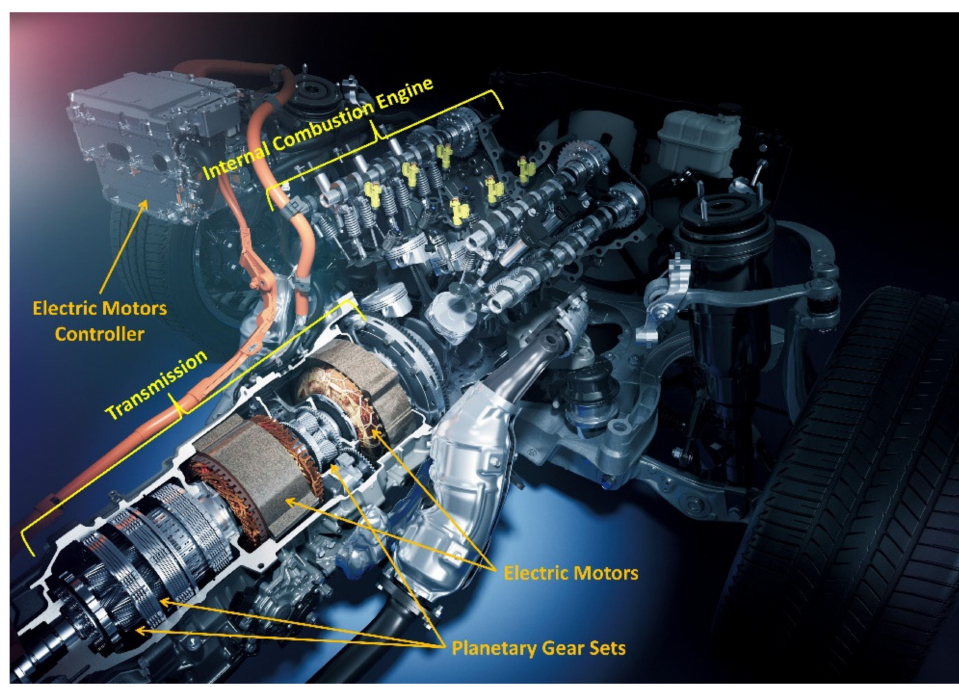
Figure 1. Toyota Multistage Hybrid System [6]. Hybrid powertrain for a passenger car composed of an internal combustion engine and an electrified transmission with two electric motors inside the planetary